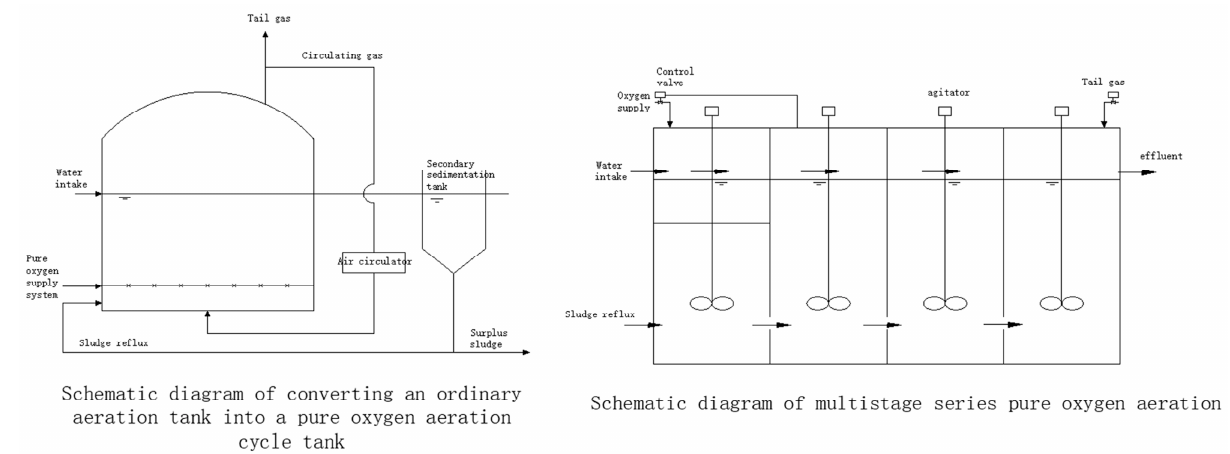
Figure 4. Process flow chart of pure ‐ oxygen ‐ aerated activated sludge method.